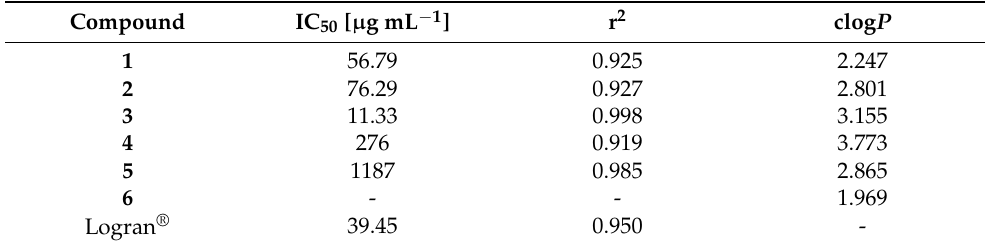
Table 2. The IC 50 and clog P values calculated from the compounds ( 1 – 6 ) and Logran ® after the wheat coleoptile bioassay using a sigmoidal dose-response variable slope